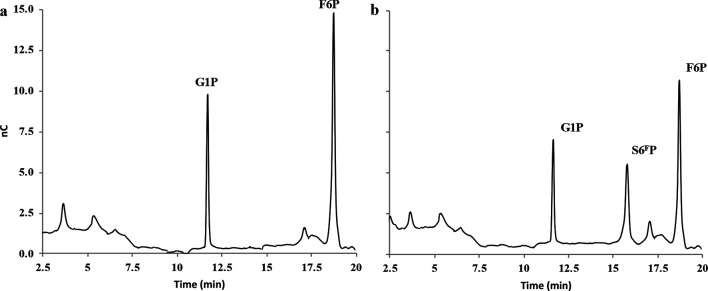
HPAEC-PAD profiles of the RgSPP reaction products obtained after 24 h in the presence of 100 µM G1P and F6P (reverse phosphorolysis). (a) Negative control and (b) assay with 0.18 µM RgSPP.